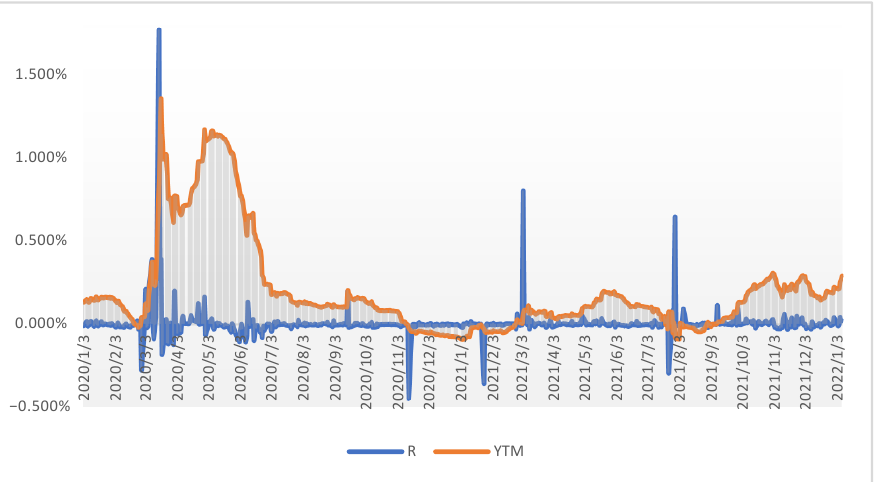
Figure 3. The volatility of the yield return and YTM of bond issue BG15/27 from 2 January 2020 to 8 January 2022. Table 5. The Conditional Value at risk for Bulgarian’s Sovereign Bonds.